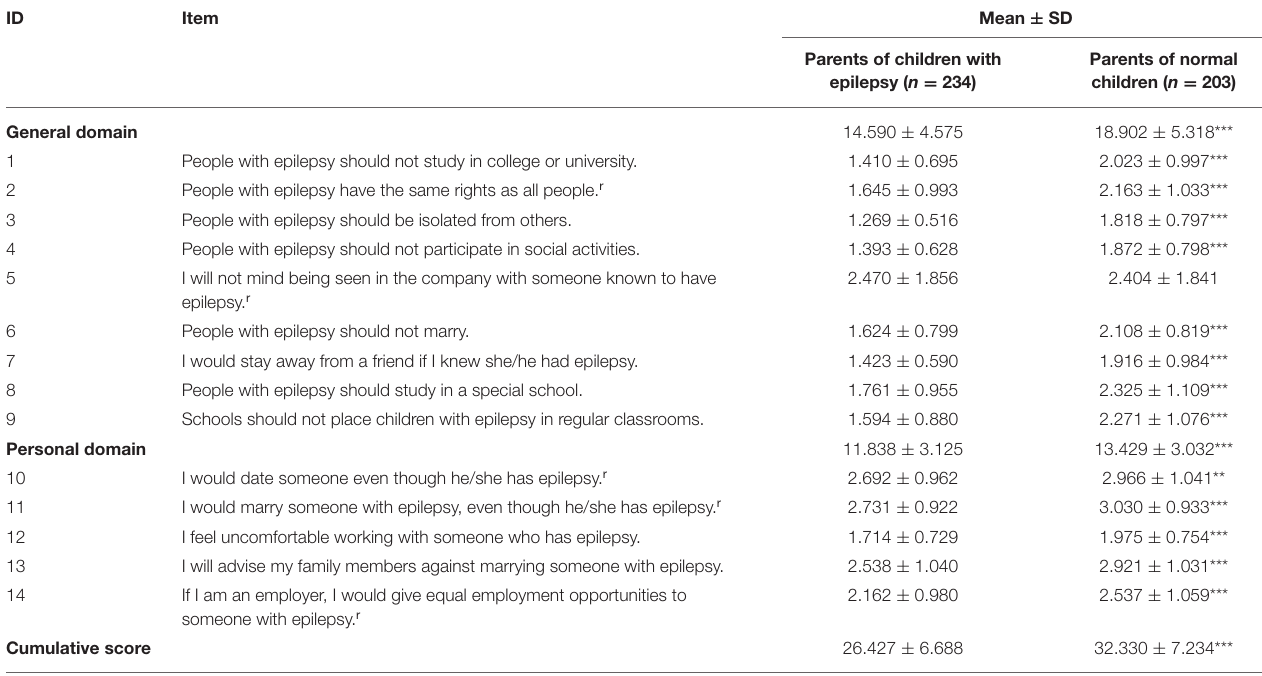
TABLE 2 | The means and standard deviations of the scores in each domain and item in parents of children and adolescents with epilepsy and the control group. ID